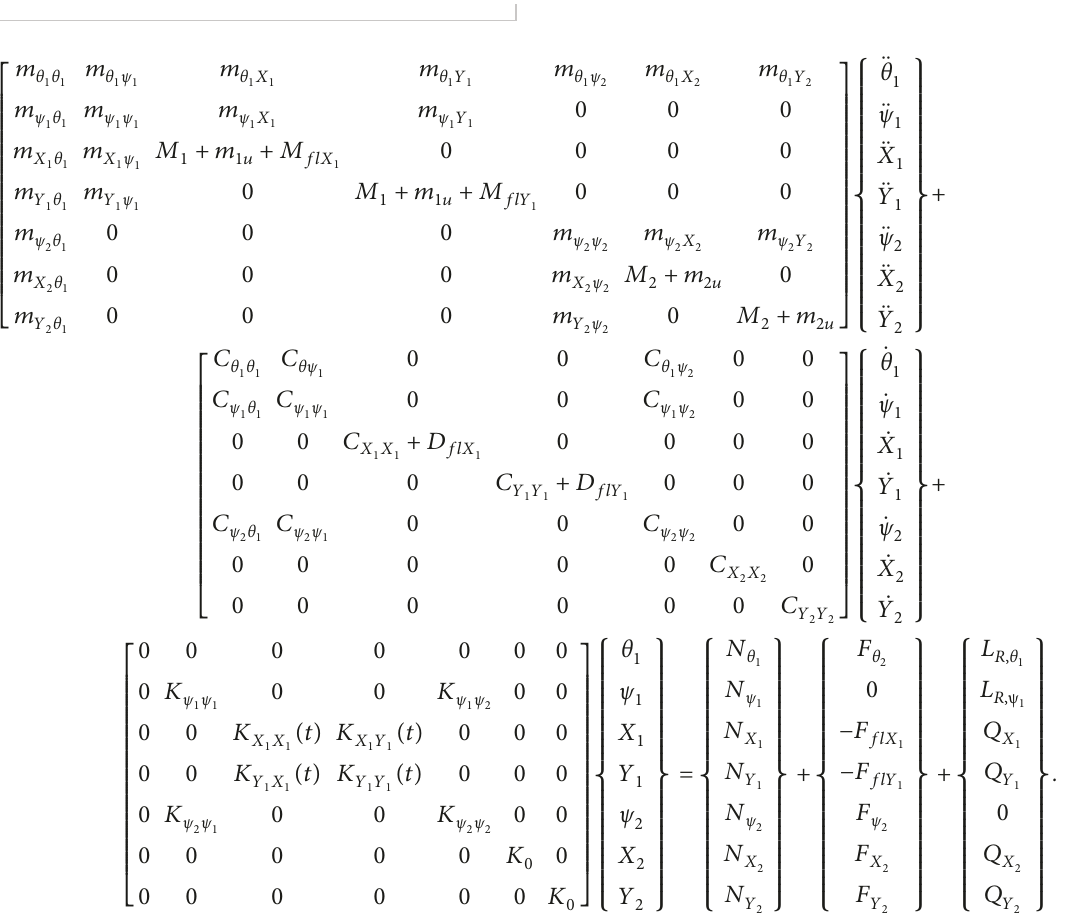
ε 1 c 0 . 3 . (b). Fluid force at various ( (cid:31) )